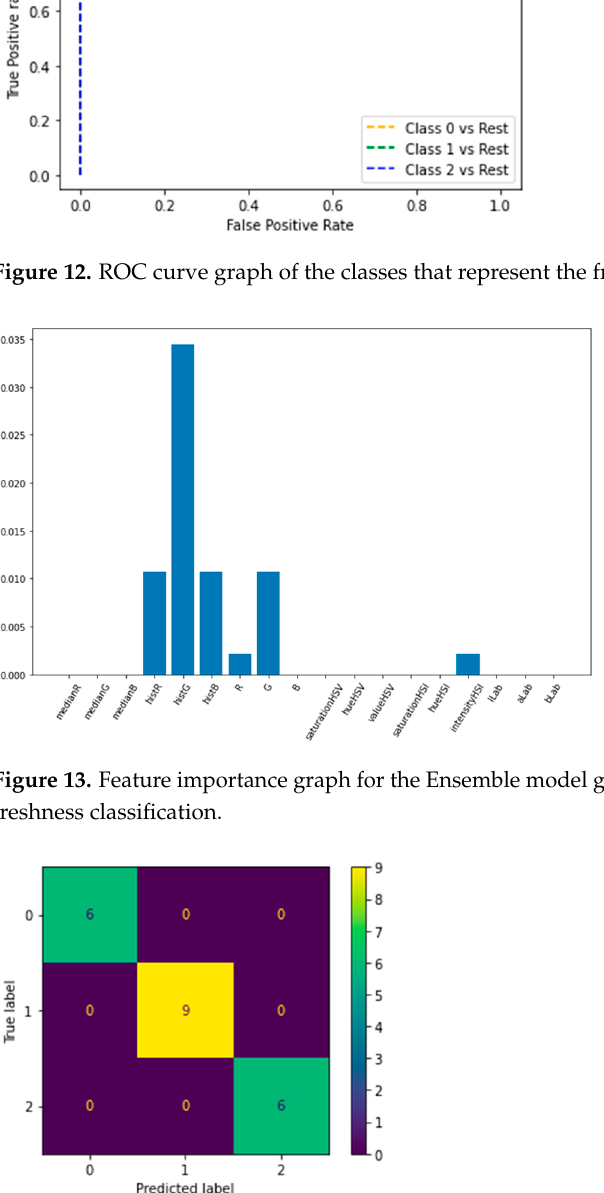
Figure 12. ROC curve graph of the classes that represent the freshness of salmon meat.